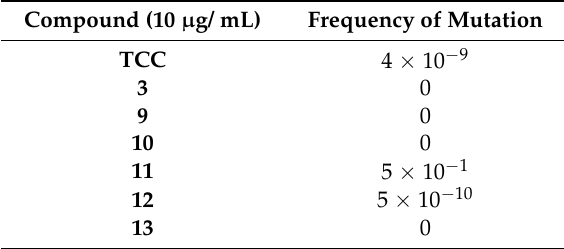
Table 2. Spontaneous mutation rates in S. aureus to different